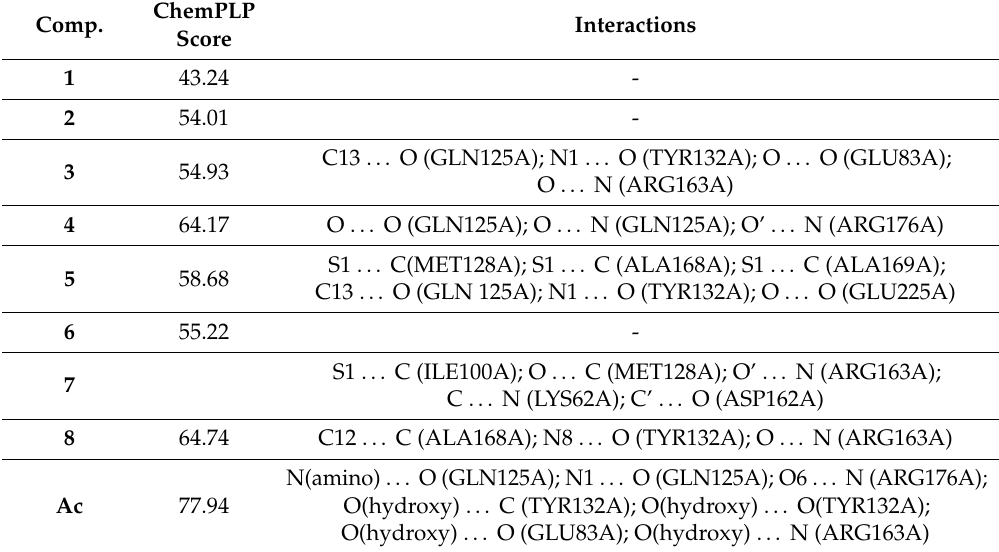
Table 6. The results of the molecular docking of ligands 1 – 8 and aciclovir molecule ( Ac ) to the TK.